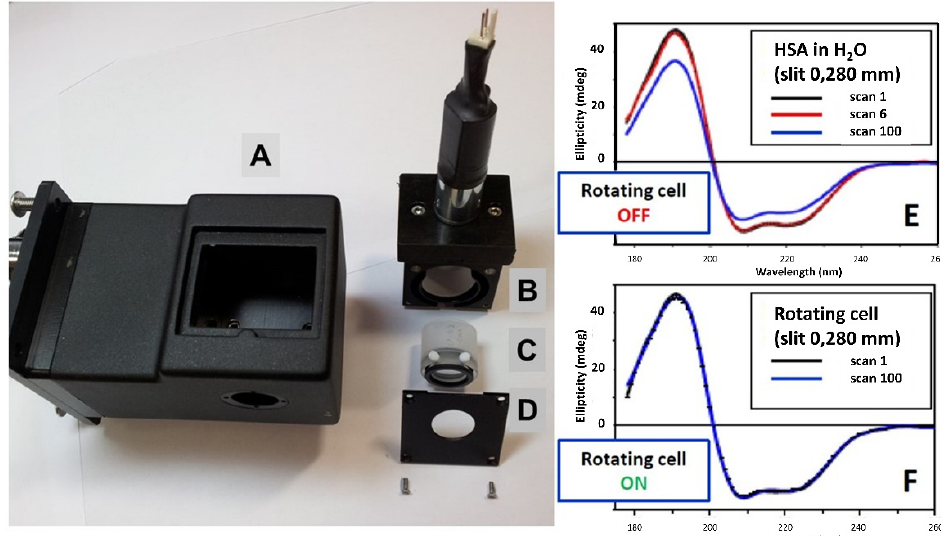
Figure 1. Motorized rotating cuvette cell holder compatible with Peltier temperature stage (5 °C to 90 °C) to eliminate in this example the protein denaturation effect from UV irradiation by up to 100 consecutive repeated scans using Diamond B23 beamline for SRCD spectroscopy. ( A ) Peltier temperature stage (Quantum Northwest, Liberty Lake, WA, USA). ( B ) Motorized rotating cylindrical cell holder. ( C ) Cylindrical cuvette cell (Hellma, Southend on Sea, U.K.). ( D ) Flat cover to enclose and enable the cuvette C to be rotated inside the cell holder B. ( E ) One hundred consecutive repeated CD spectra of aqueous human serum albumin (HSA) using a 0.280 mm slit width corresponding to 0.7 nm bandwidth measured with the rotating cell holder switched OFF. For clarity, only the 1st, 6th, and 100th scans are reported to illustrate the spectral changes induced by the UV irradiation. ( F ) One hundred consecutive repeated CD spectra measured under continuous rotation with the motorized rotating cell holder switched ON. The 100 spectra of HSA are superimposed, indicating no protein denaturation after 100 consecutive repeated scans.